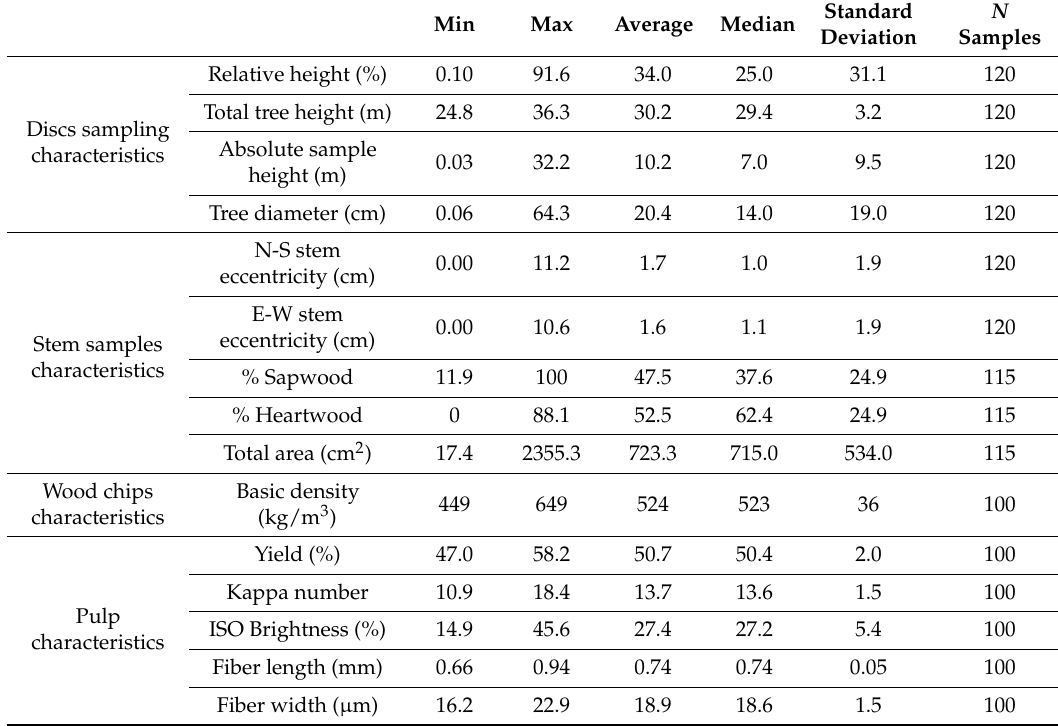
Table 1. Basic descriptive statistics for the parameters that compose our dataset.